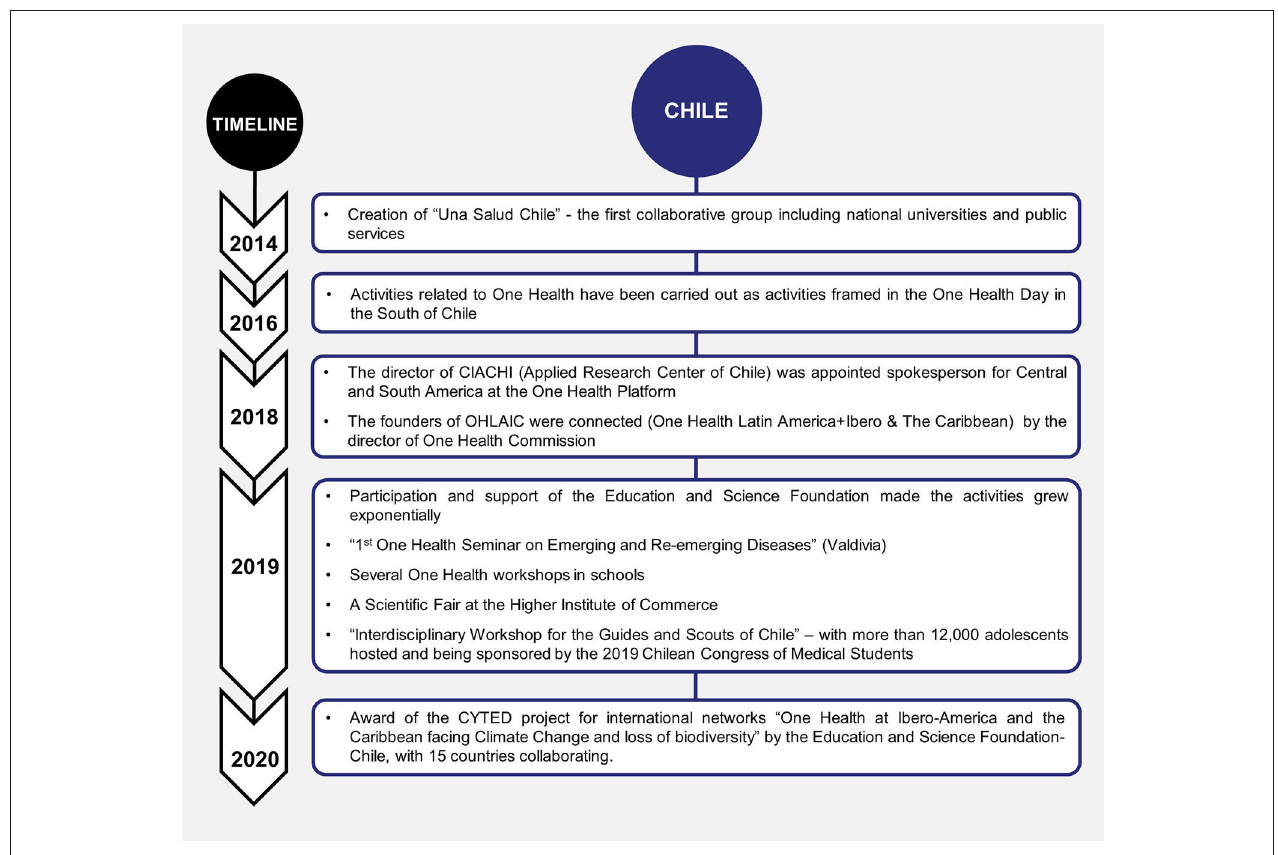
FIGURE 2 | One Health history and development in the last decades in